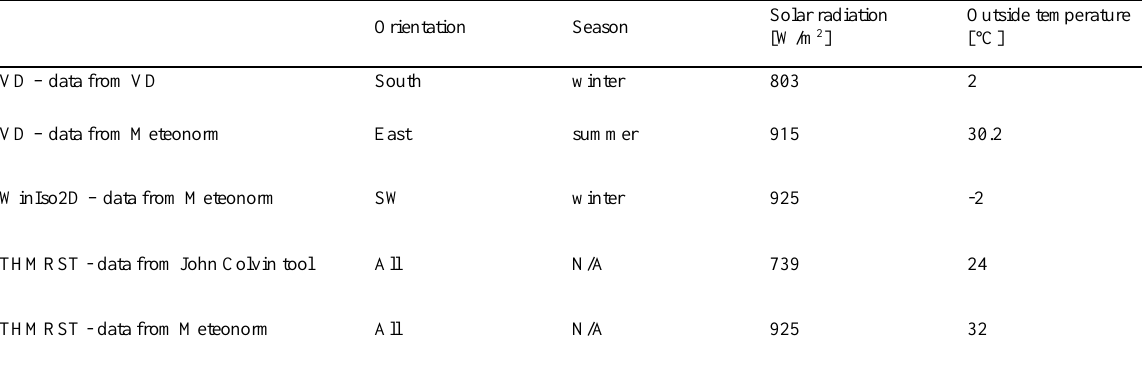
Table 6: THE MOST CRITICAL CLIMATIC DATA FOR PANE 2 for max. ∆